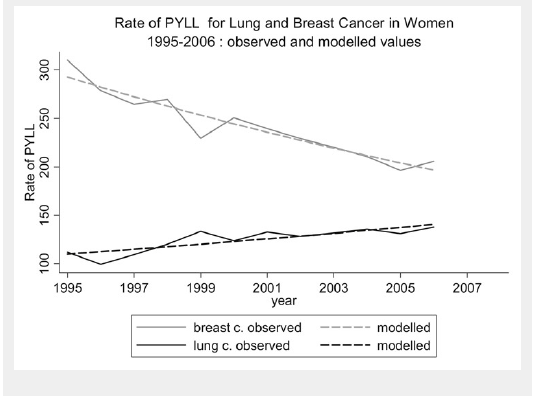
Breakpoint in slope of rate of PYLL for traffic accidents in men in 2004, coinciding with the reduction of the maximum blood alcohol level permitted for drivers to 0.5‰ in 2005